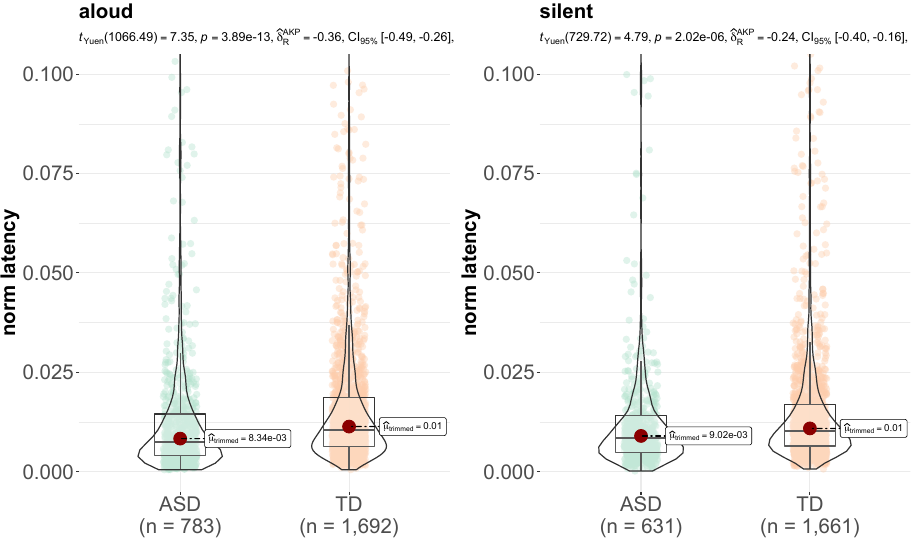
Figure 9. Distributions of normalized latency time for weak punctuation in ASD and TD children in the aloud ( left ) and silent ( right ) reading modality (plot obtained with the ggplot2 packages, function ggbetweenstats